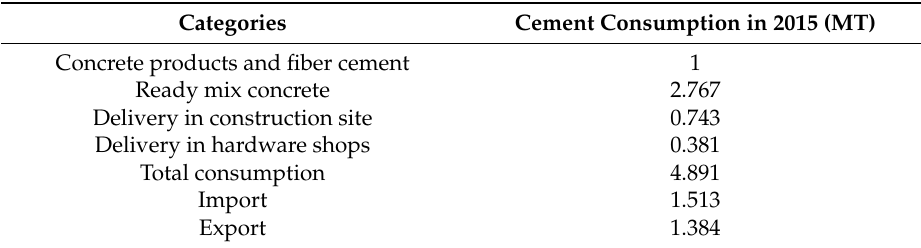
Table 6. Cement consumption in Belgium cf. [134].